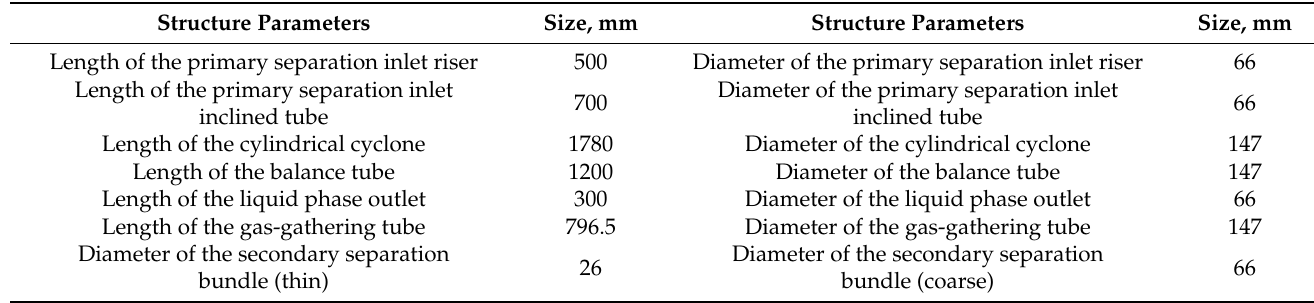
Table 1. Geometrical parameters of the physical model.